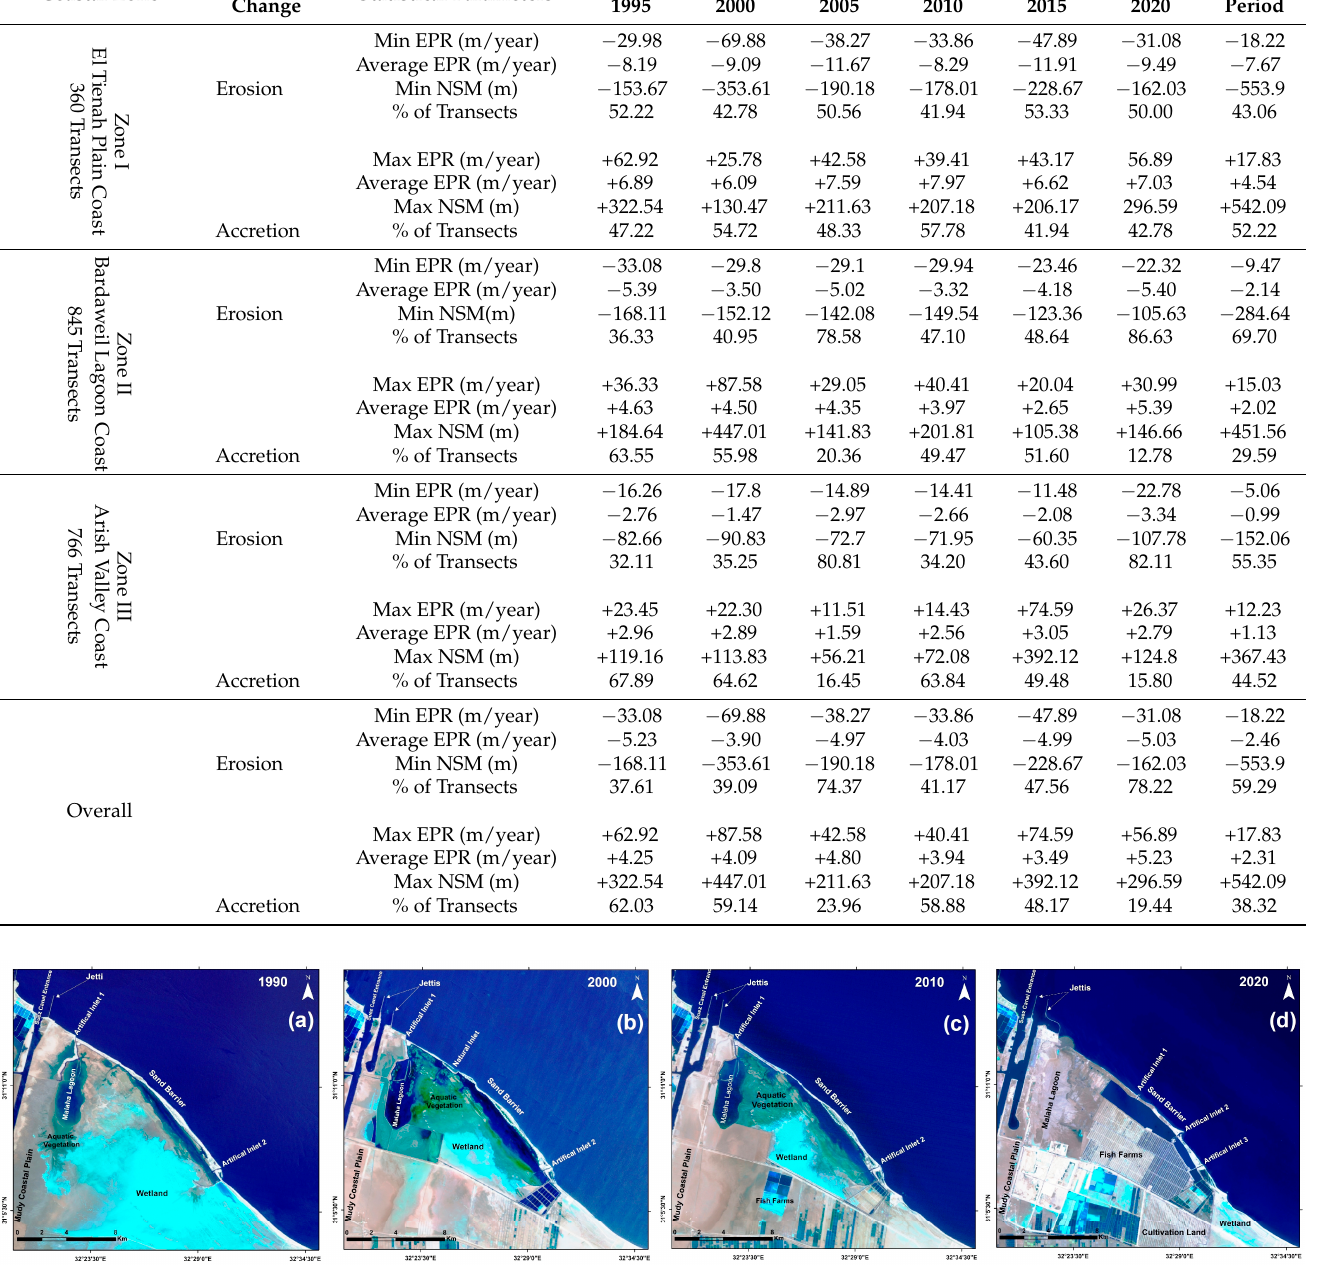
Figure 9. Land Use/Land Cover Changes along the El Tienah Plain. ( a ) 1990 Landsat-5; ( b ) 2000 Landsat-7; ( c ) 2010 Landsat-5; and ( d ) 2020 Landsat-8. A Coastal Erosion Decision Matrix (CEDM) was created for each zone according Between 2010 and 2015, the coastline retreated 228.7 m at an average annual rate of 11.9 m/yr. It was the highest average annual rate for the SMC during the study period. A natural inlet formed in the Mallaha Coastal Barrier, as well as an underwater groin south- ward. Between 2015 and 2020, the eastern jetty of the Suez Canal entrance was extended to protect a larger area as well as two artificial inlets which were constructed along the Al Mallaha Lagoon sand barrier. Both are protected with two parallel jetties to avoid insta- bility of bank erosion and sedimentation, as shown in Figure 10.